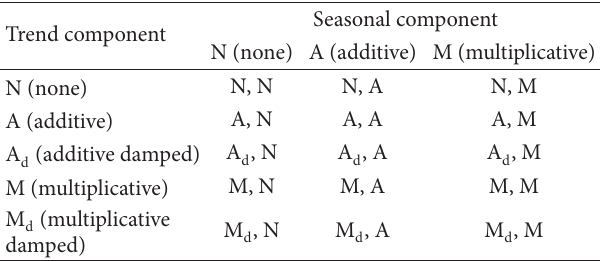
Table 1: Classification and summary of ETS models. Trend component